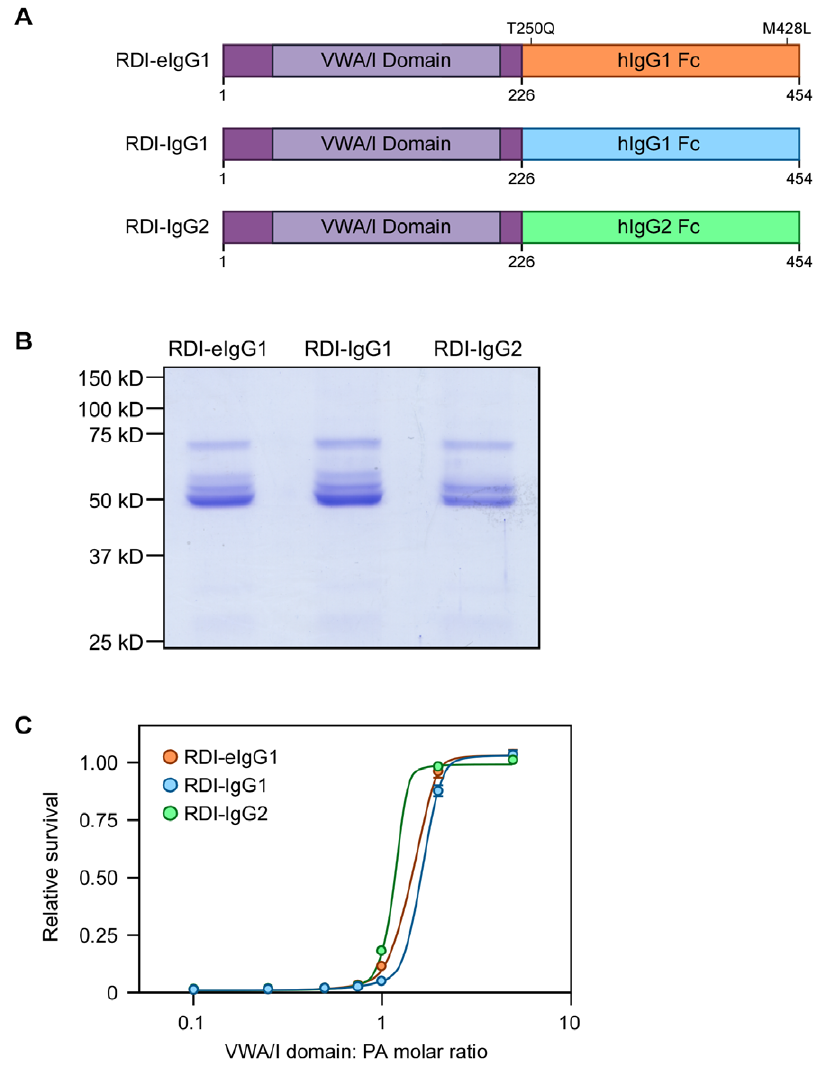
Figure 6. Construction of RDI fusion proteins with IgG1 or IgG2 Fc portions. A. Schematic of the RDI and Fc portions of the fusion proteins. B. SimplyBlue stained gel of RDI-eIgG1, RDI-IgG1, or RDI-IgG2 separated on 10% SDS-PAGE. Molecular weight markers are indicated. C. Inhibition of LeTx activity in RAW264.7 cells by RDI-eIgG1, RDI-IgG1, and RDI-IgG2.